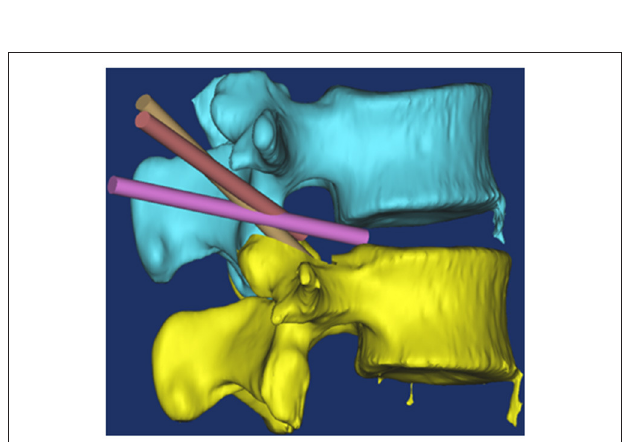
FIGURE 5 | Schematic diagram of endoscopic multi-plane nerve root canal decompression technique. The yellow channel position displayed that directly decompresses superior segment of the mid zone of the lateral lumbar spinal canal; Brown channel position displayed that the working casing was adjusted, the posterior longitudinal ligament and annulus fibrosus were incised; Purple channel displayed that the herniated disc tissue was